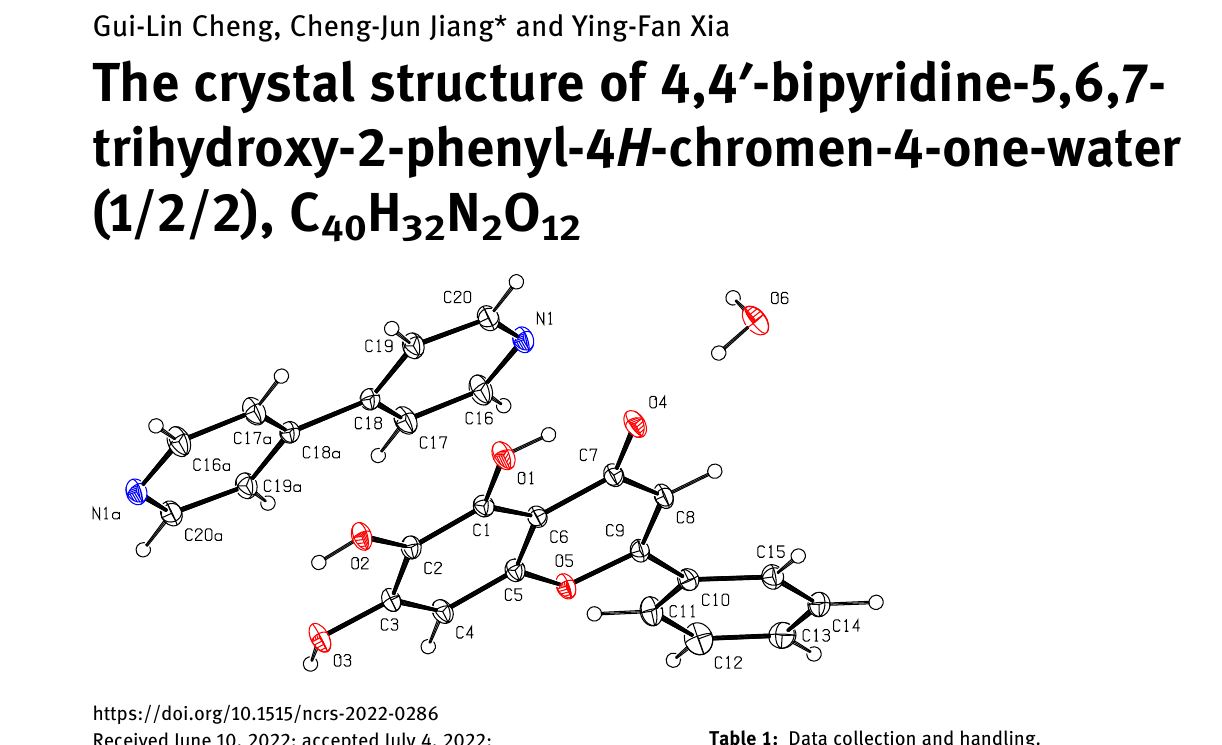
Table  : Data collection and